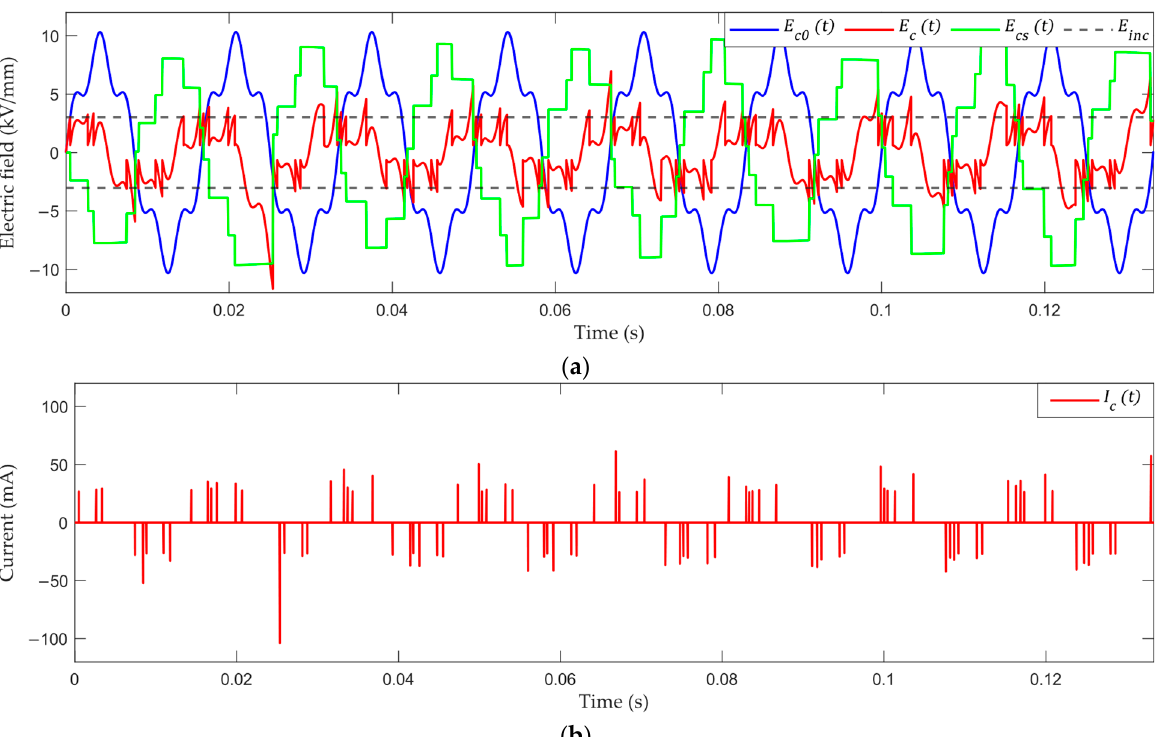
Figure 6. Simulated results for the case wherein a voltage distorted by the 5th harmonic component with 𝜑 (cid:3035) = 0° and THD = 20% was applied: ( a ) electric fields over time; ( b ) PDs’ current pulses.